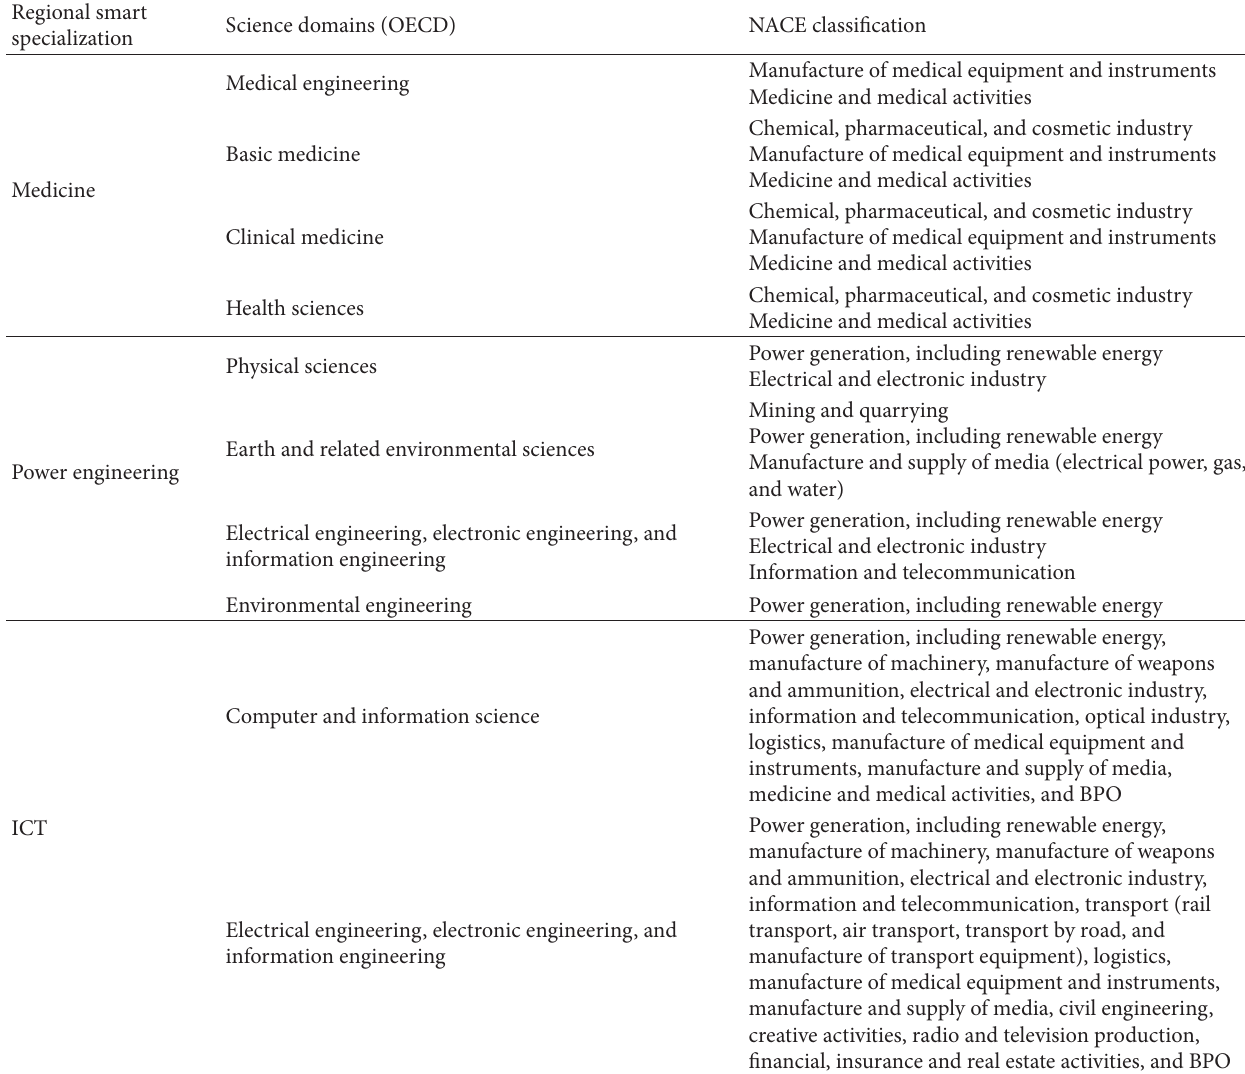
Table 7: Interrelations between economy and science sectors for regional smart specialization of medicine, power engineering, and ICT (the sixth